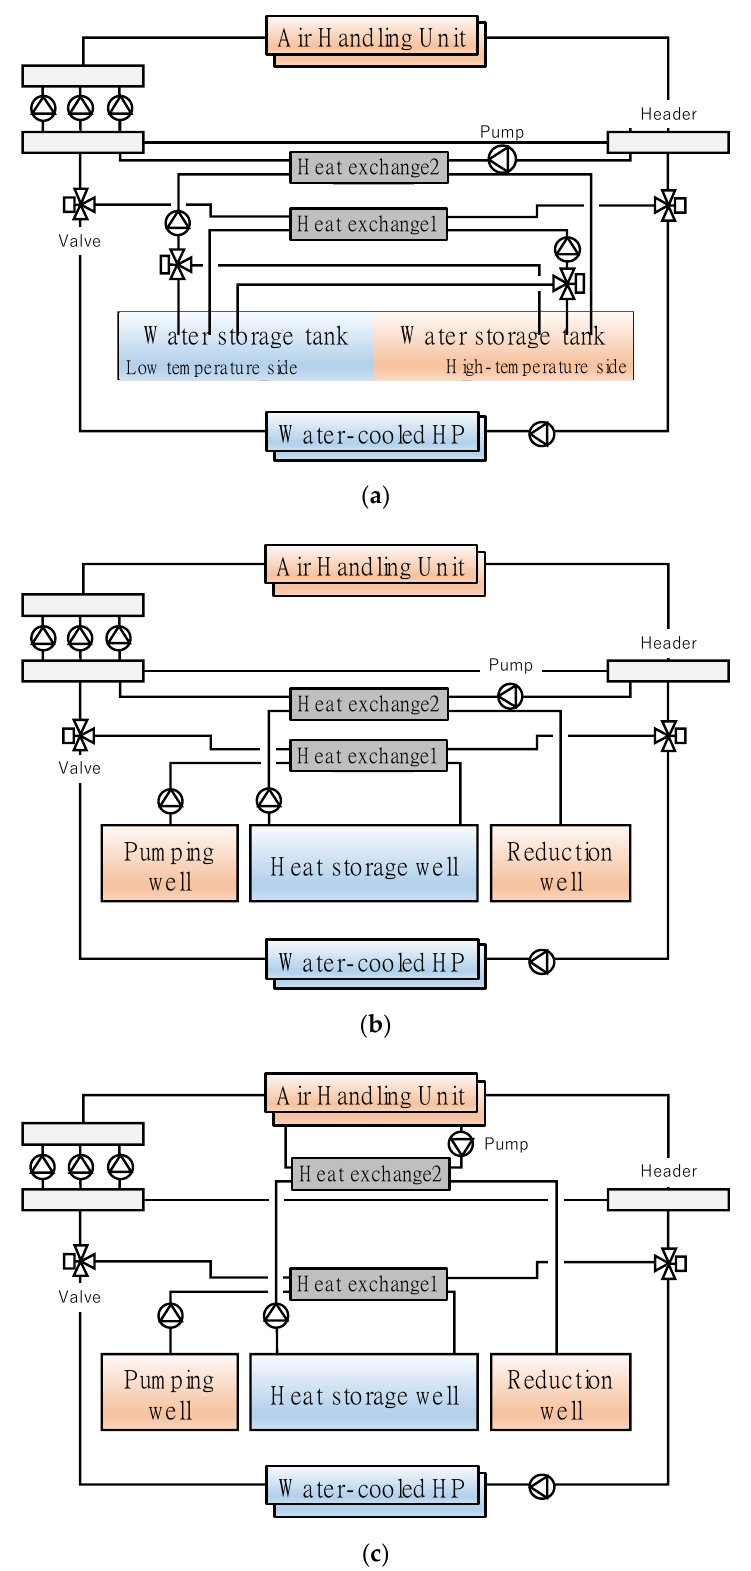
Figure 7. Air conditioning system diagram in each system. ( a ) WTES system. ( b ) ATES system. ( c ) ATES system (pre-cooling/pre-heating).